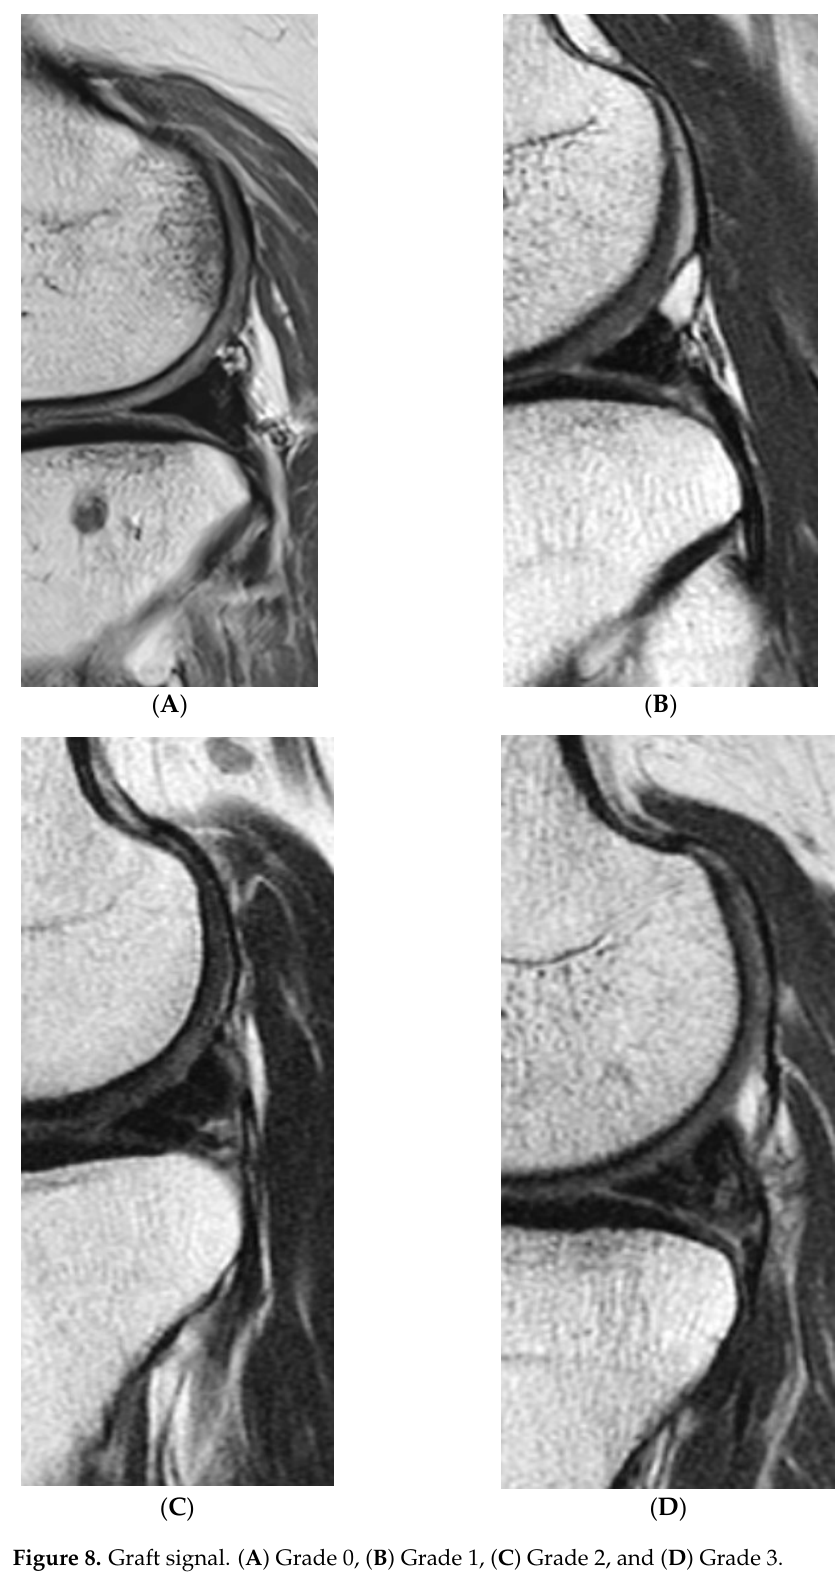
Figure 7. The absolute sagittal anterior horn extrusion ( a ) and posterior horn extrusion ( b ). Graft signal was assessed using MRI at 12 months, postoperatively, and graded fol- lowing Park et al. [31]: grade 0 (normal), grade 1 (globular increased signal intensity), grade 2 (linear signal intensity within the meniscal graft), and grade 3 (diffuse increased signal intensity or communicated to the articular surface) (Figure 8). This grading was applied for five sections: anterior root, anterior third of the meniscal graft, mid-body, posterior third of the meniscal graft, and posterior root.